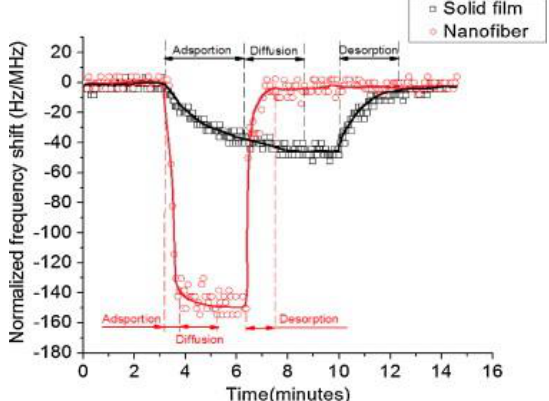
Figure 8. Comparison of the sensor responses of polyethylene oxide processed in two different forms, i.e., a solid film and nanofibers , explaining the adsorption, diffusion and desorption processes. It is obvious that polyethylene oxide nanofibers offer high sensitivity and faster kinetics. Adapted with permission from [132], copyright (2011) Elsevier.